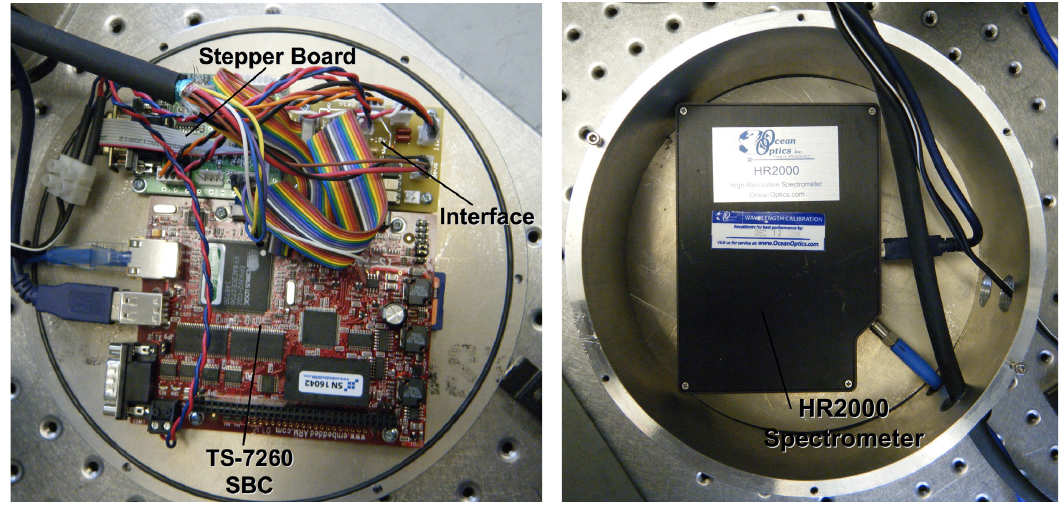
Fig. 4. The computer/spectrometer subsystem. In left panel is the top of the housing, where we have mounted the single-board computer (SBC), stepper motor driver, and interface circuit boards. The right panel shows the Ocean Optics HR2000 spectrometer thermally contacted to the aluminum housing